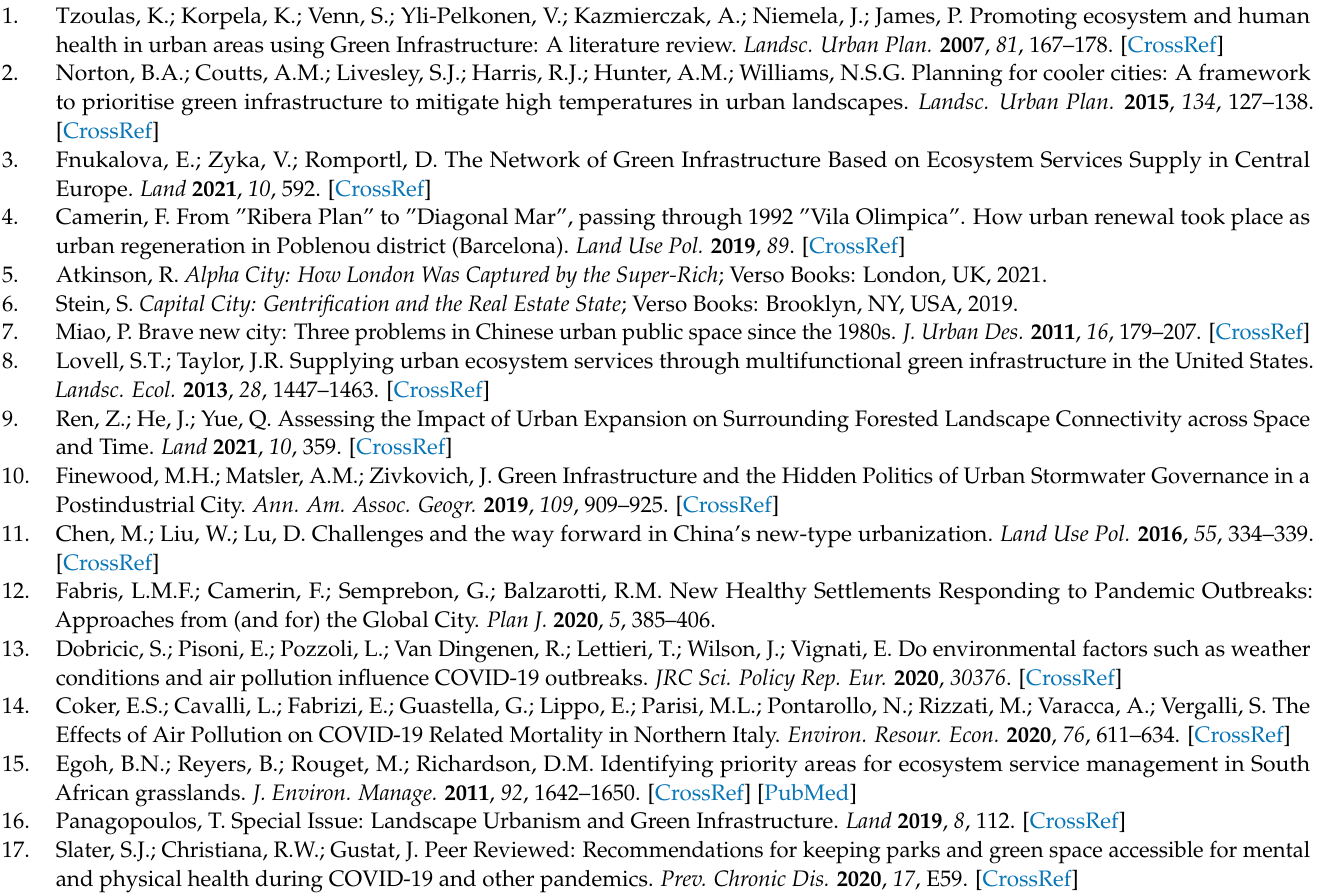
Figure S2: Landscape types in the study area by MSPA, Figure S3: The integrated resistance surface of the study